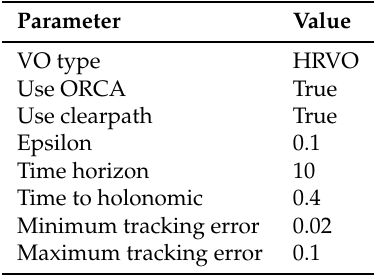
Table 1. Hyper-parameters of the NH-ORCA algorithm used in our comparison experiments.